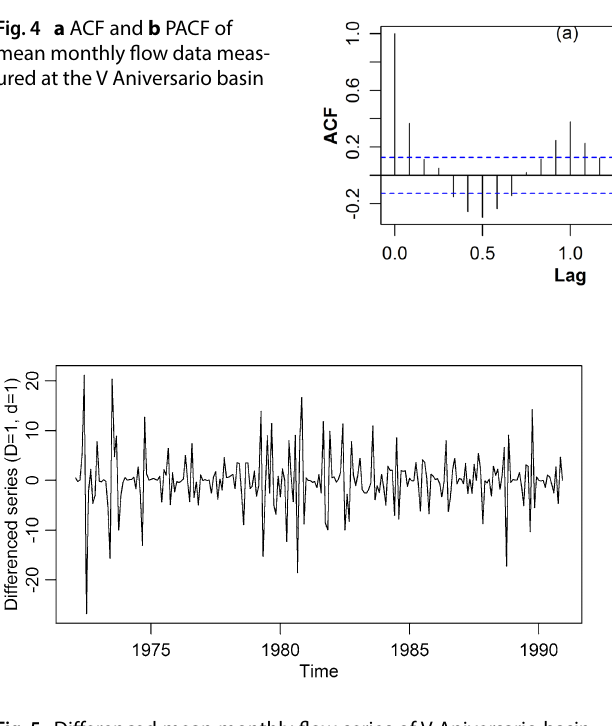
Fig. 5 Differenced mean monthly flow series of V Aniversario basin (period 1971–1988)